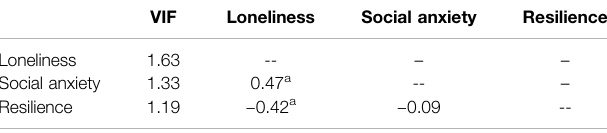
TABLE 3 | Relations Between Individual-Level Risk factors, Demographic Variables, and Entirety of Season Viewed. OR